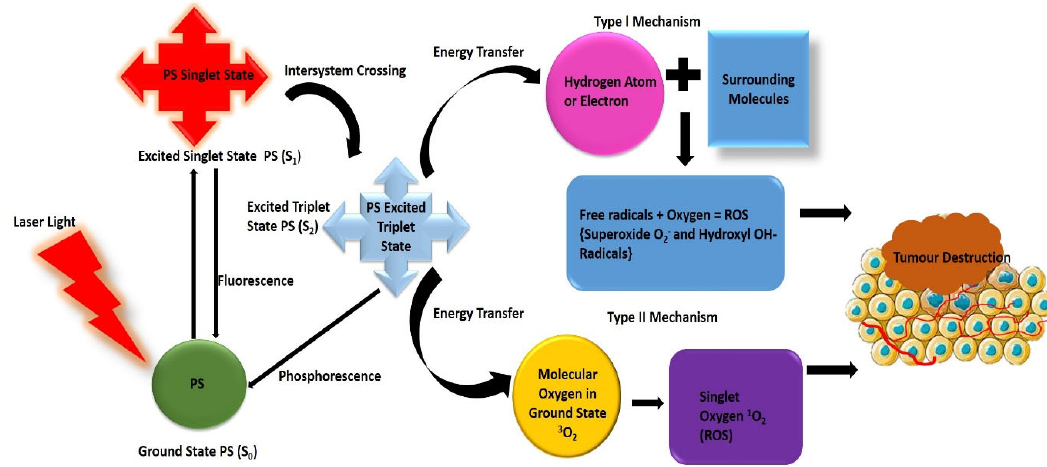
Figure 2. Graphical presentation of photodynamic therapy (PDT) mechanism. Created based on the literature references [10,14].